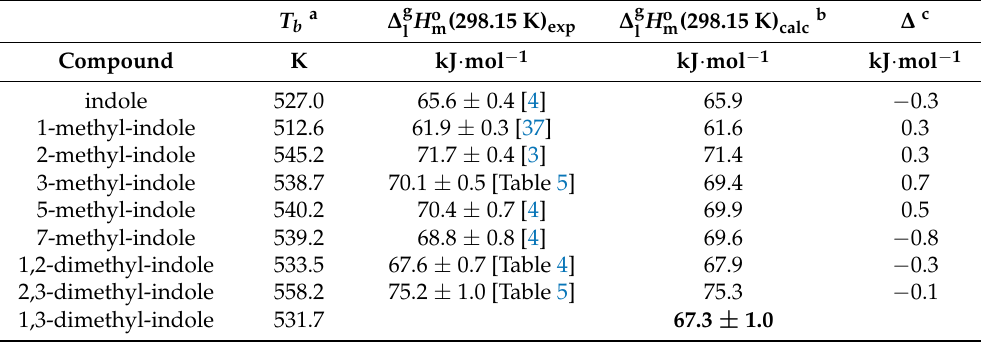
Table 7. Correlation of the vaporization enthalpies ∆ g normal boiling